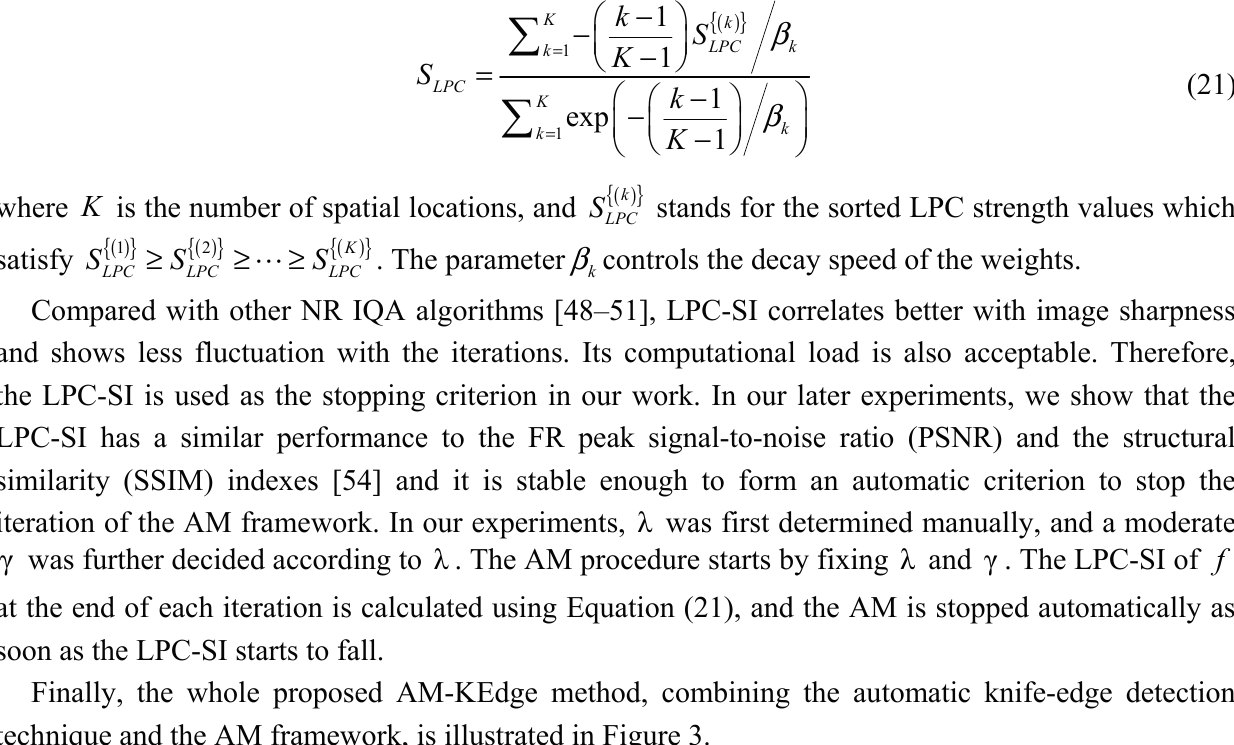
Figure 3. The framework of the proposed AM-KEdge